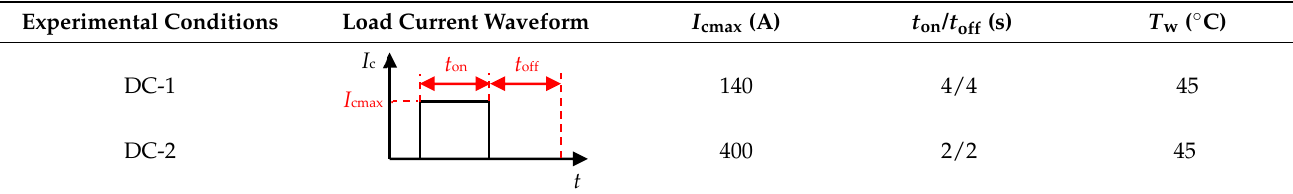
Table 3. Experimental conditions for IR temperature measurement.